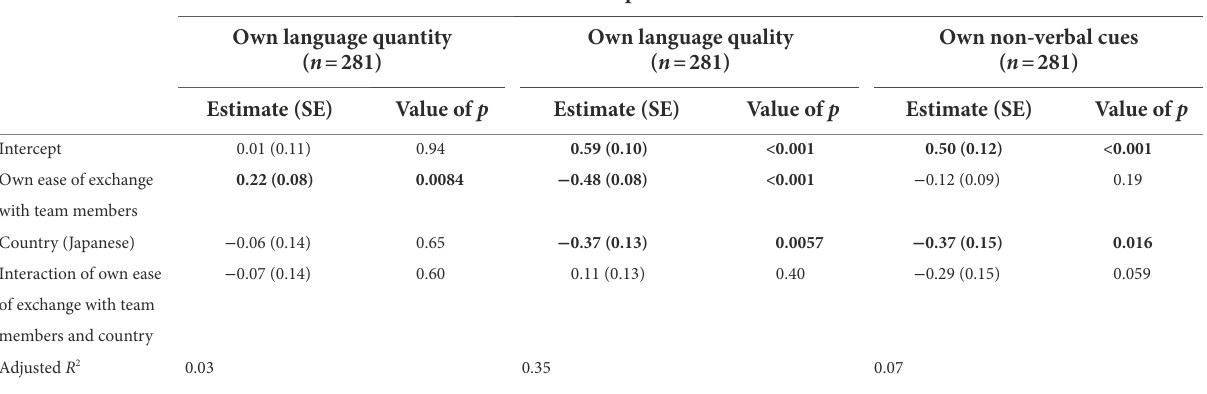
TABLE 9 The linear regression models predicting educators’ own communicative behavior toward team